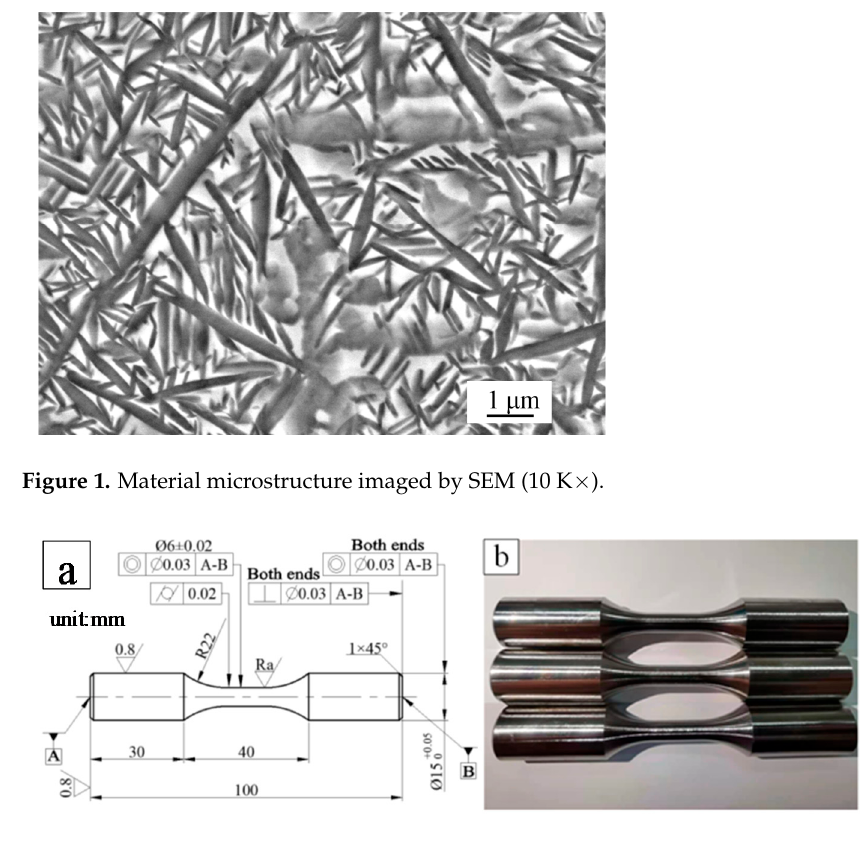
Figure 2. Configuration of fatigue specimen. ( a ) geometry design plan; ( b ) photo of specimens. Table 2. The processing parameter sets correspond to different target